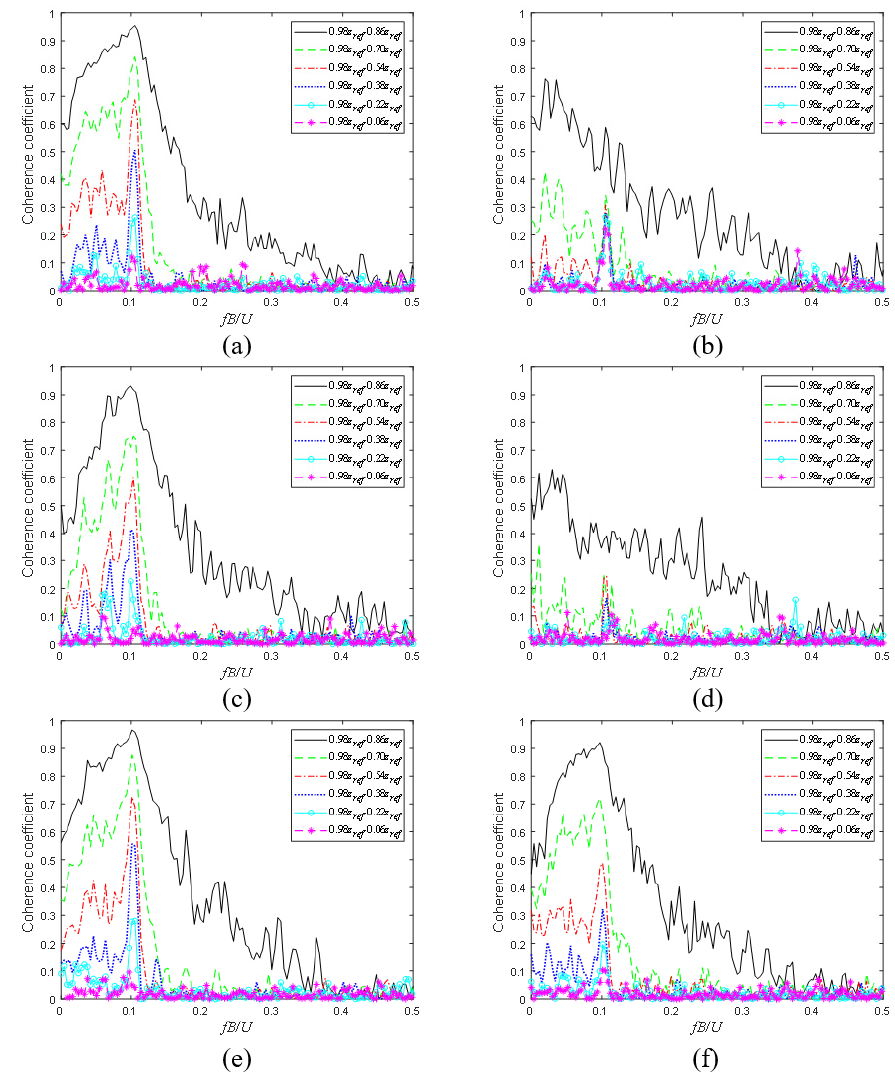
Figure 20. Coherence coefficients of across-wind load among different layers: ( a ) CWF1-0°; ( b ) CWF1-30°; ( c ) TWF30-0°; ( d ) TWF30-30°; ( e ) CWF2-0°; and ( f ) TWF20-0°.